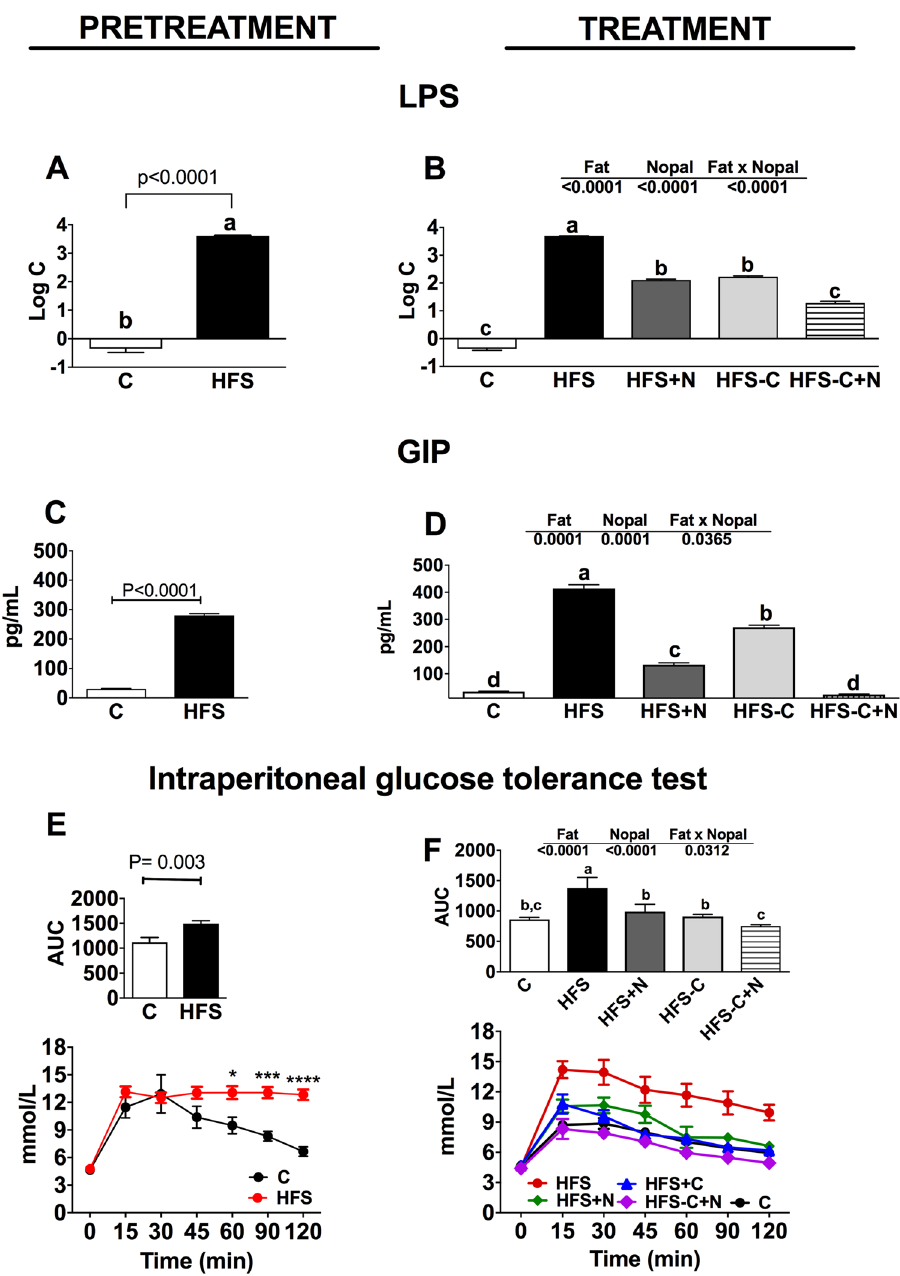
Figure 6. Nopal consumption decreases metabolic endotoxemia, prevents the hypersecretion of glucose insulinotropic peptide (GIP) and improves glucose tolerance. Fasting serum lipopolysaccharide (LPS) after the pretreatment ( A ) and treatments ( B ) periods. Serum GIP after the pretreatment ( C ) and treatments ( D ) periods. ipGTT and area under curve (AUC) after the pretreatment ( E ) and treatments ( F ) periods. Wistar rats were fed one of the following diets: control diet ( C ), high fat diet with 5% sucrose in their drinking water (HFS), HFS + 5% nopal (HFS + N), and obese rats switched to C diet with (HFS-C + N) or without (HFS-C) 5% nopal. Data are expressed as mean ± SEM (n = 5/group). Comparisons among groups were analysed by 2-way ANOVA followed by Fisher’s PLSD test. Different letters indicate significant differences among groups (a > b > c > d). P < 0.05. Comparisons between two groups were analysed by student t